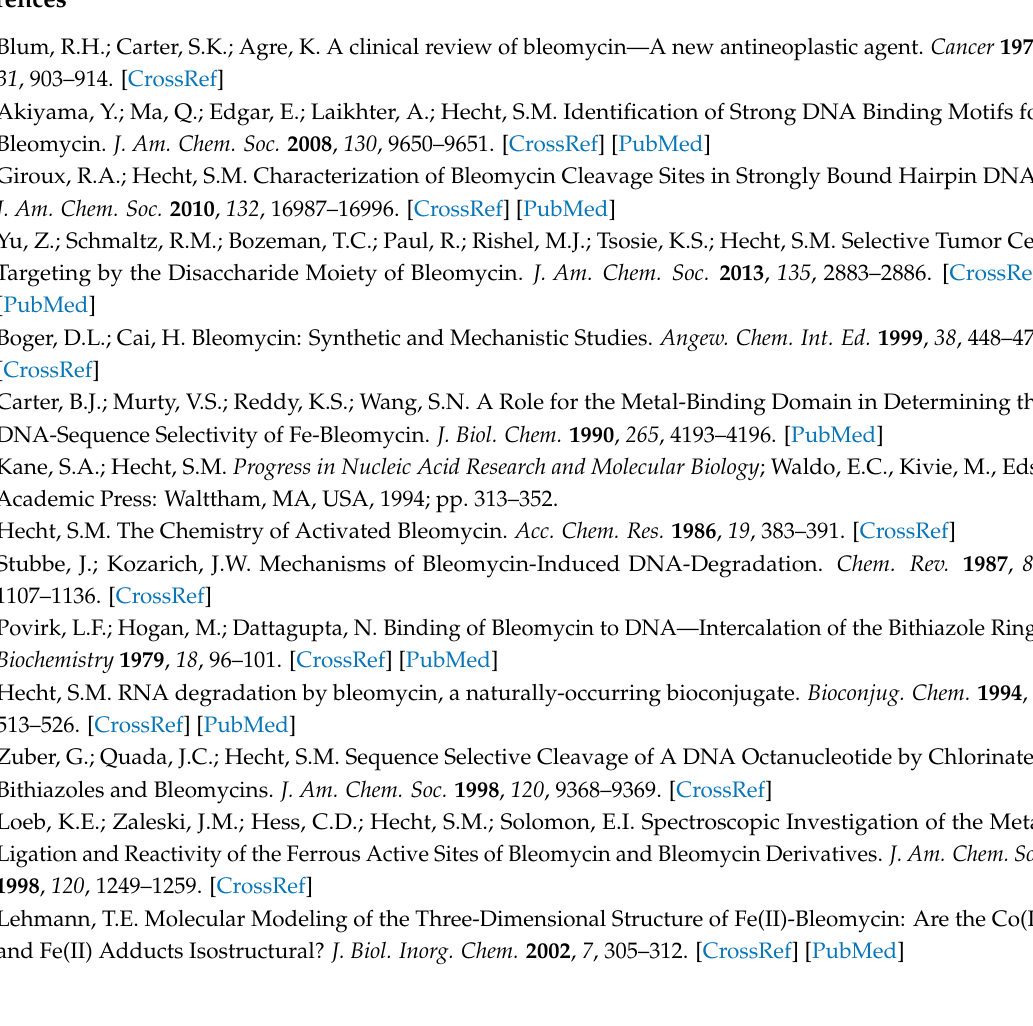
Figure S1: NOESY spectra for both free Zn(II)BLM-A 2 and Zn(II)BLM-A 2 bound to each of the DNA strands under study, Figure S2: NOESY spectra for both free Zn(II)PEP and Zn(II)PEP bound to each of the OLs under study, Figure S3: NOESY spectra for both free Zn(II)BLM-B 2 and Zn(II)BLM-B 2 bound to each of the OLs under study, Figure S4: NOESY spectra for both free Zn(II)BLM-A 5 and Zn(II)BLM-A 5 bound to each of the DNA strands under study, Table S1: Chemical shifts for the bleomycin residues for each of the free Zn(II)BLMs under study, Table S2: Inter-residue intramolecular NOEs for free Zn(II)BLM-A 2 and Zn(II)BLM-A 2 bound to both OLs, Table S3: Intra-residue intramolecular NOEs for free Zn(II)BLM-A 2 and Zn(II)BLM-A 2 bound to both OLs, Table S4: Inter-residue intramolecular NOEs for free Zn(II)PEP and Zn(II)PEP bound to both OLs, Table S5: Intra-residue intramolecular NOEs for free Zn(II)PEP and Zn(II)PEP bound to both OLs, Table S6: Inter-residue intramolecular NOEs for free Zn(II)BLM-B 2 and Zn(II)BLM-B 2 bound to OL 1 , Table S7: Intra-residue intramolecular NOEs for free